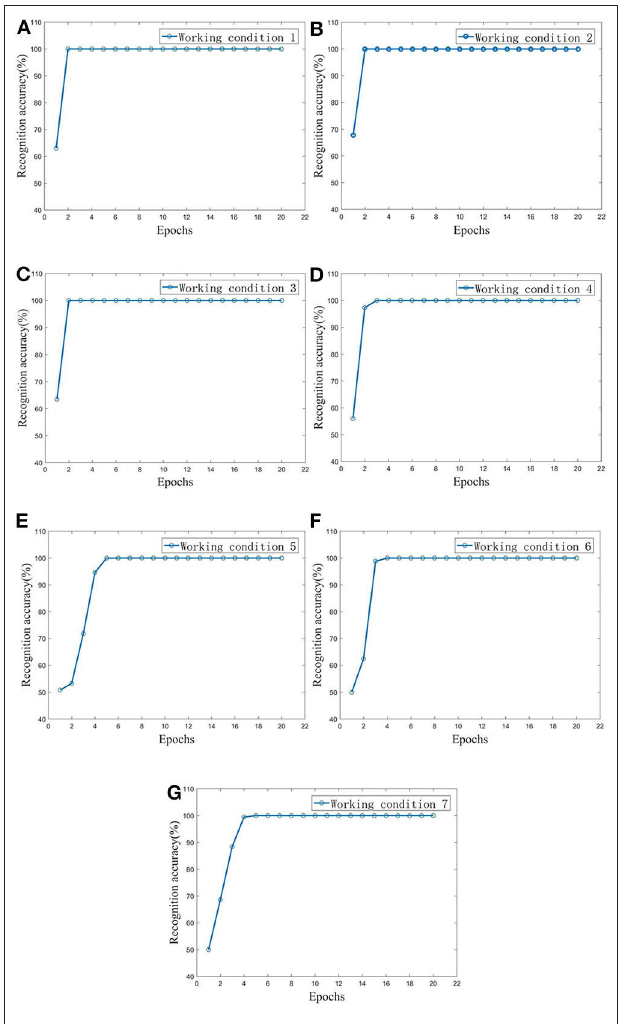
FIGURE 14 | The identification accuracies of seven working conditions during the CNN training process. (A) Working condition 1. (B ) Working condition 2. (C) Working condition 3. (D) Working condition 4. (E) Working condition 5. (F) Working condition 6. (G) Working condition 7.